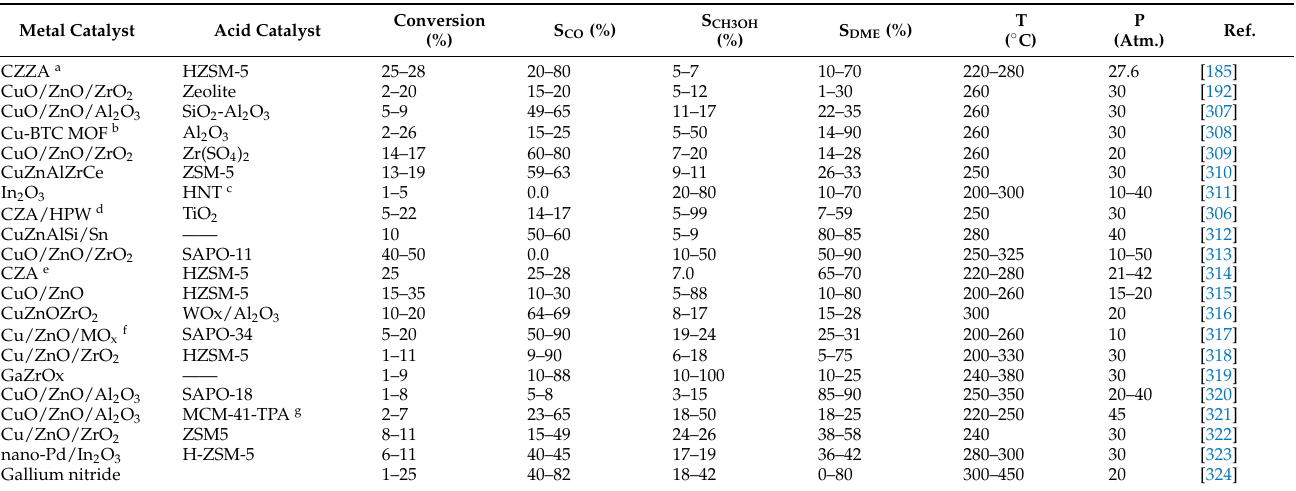
Table 9. Comparative summary of different bifunctional/hybrid catalytic systems for improving the direct conversion of CO 2 to DME.